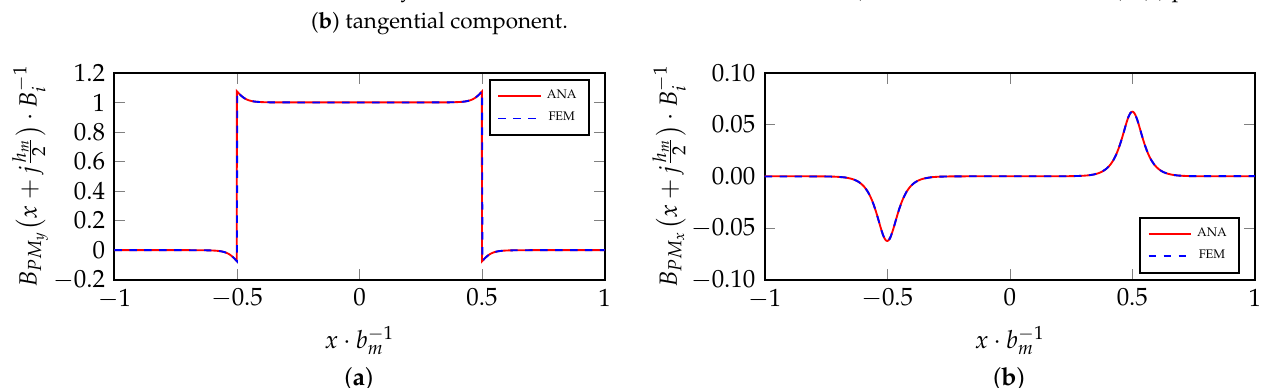
b m x b m N x = 1000). ( a ) p.u. normal; − ≤ ≤